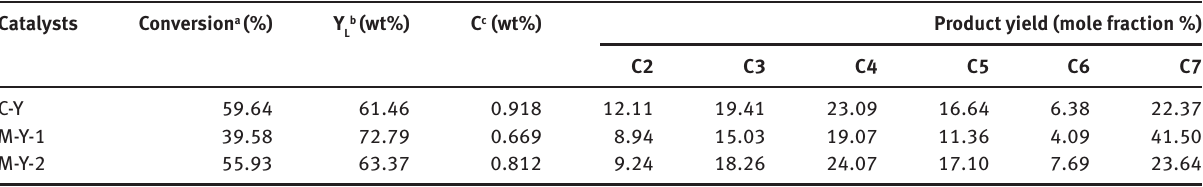
Table 3: The hydrocracking reaction results of n-heptane by different catalysts.